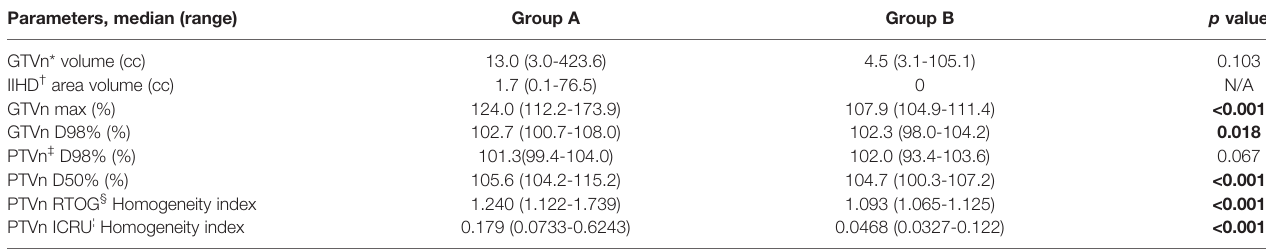
TABLE 3 | Dose-volume histogram analyses in group A and B. Parameters, median (range)